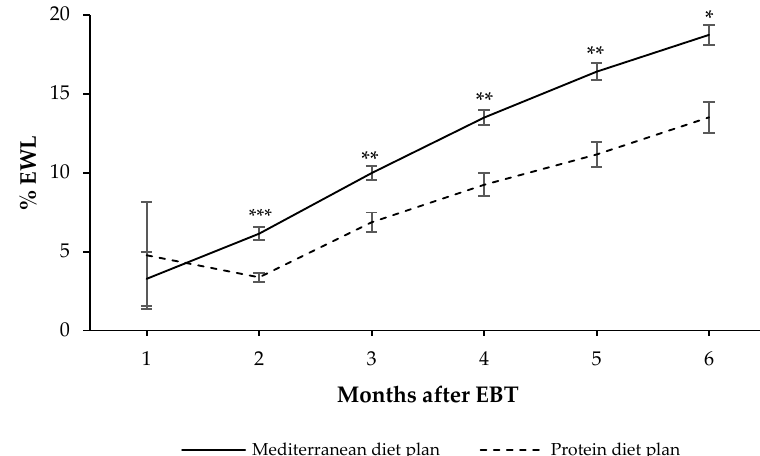
Figure 1. Effectiveness of weight loss expressed as percentage of excess weight loss (%EWL) six months after the endoscopic bariatric therapy (EBT) according to the diet plan followed. Values are expressed as mean and standard error measure. General linear models adjusted for age, gender and type of EBT were used to compare differences in weight loss between groups. * p < 0.05, ** p < 0.01, and *** p < 0.01.